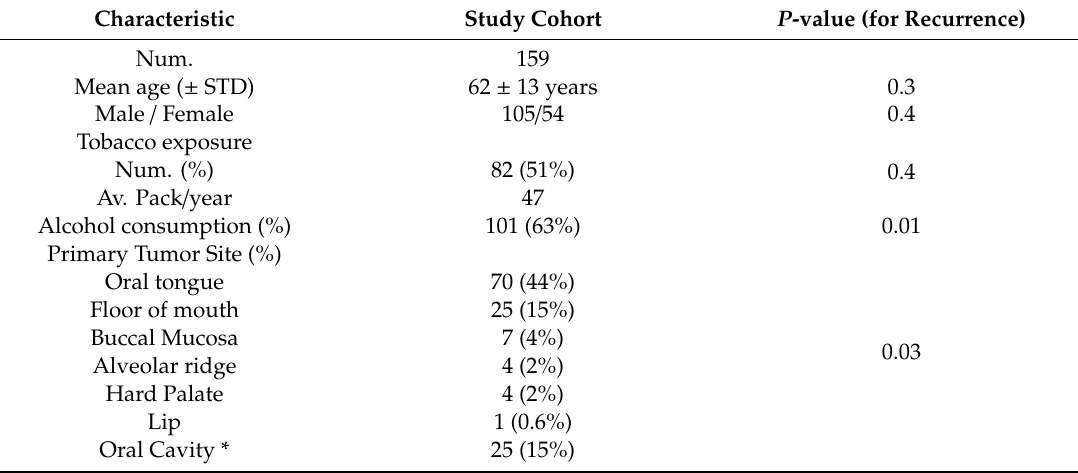
Table 1. Clinical and disease-related data of the study